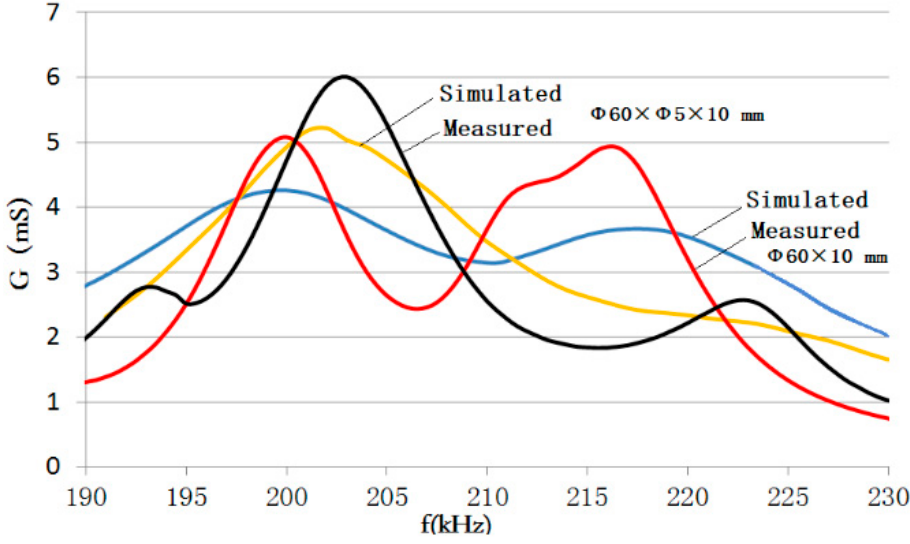
Figure 8. Conductance curve of two transducers in water.